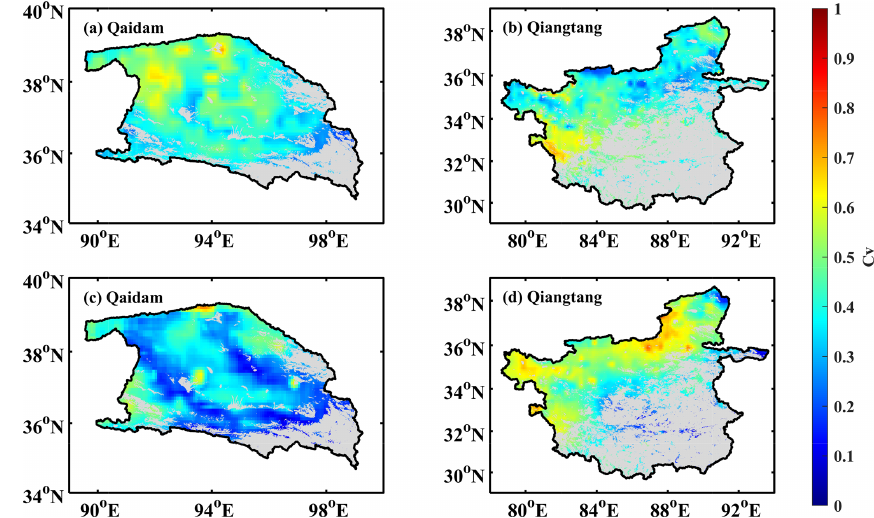
Figure 11. Maps of the coefficients of variation of (a, b) five soil moisture datasets and (c, d) five precipitation datasets in (a, c) the Qaidam Basin and (b, d) the Qiangtang Plateau. Each soil moisture or precipitation dataset is the monthly average value from 2003 to 2011. The gray indicates the non-barren areas within the basin. Table 3. RMSE (mm), Bias (mm), NSE, and R 2 of the five ET P-LSH_ θ and five ET P-LSH_P in comparison with the ET recon for aggregation of two basins. Soil moisture ET P-LSH_ θ Precipitation ET P-LSH_P sources RMSE Bias NSE R 2 sources RMSE